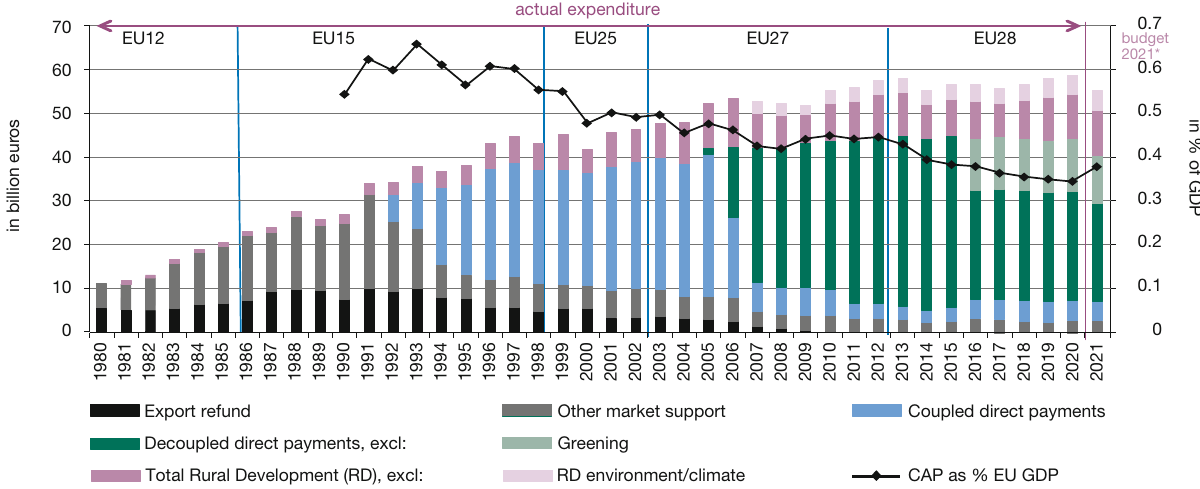
Figure 1 The evolution of CAP expenditure current